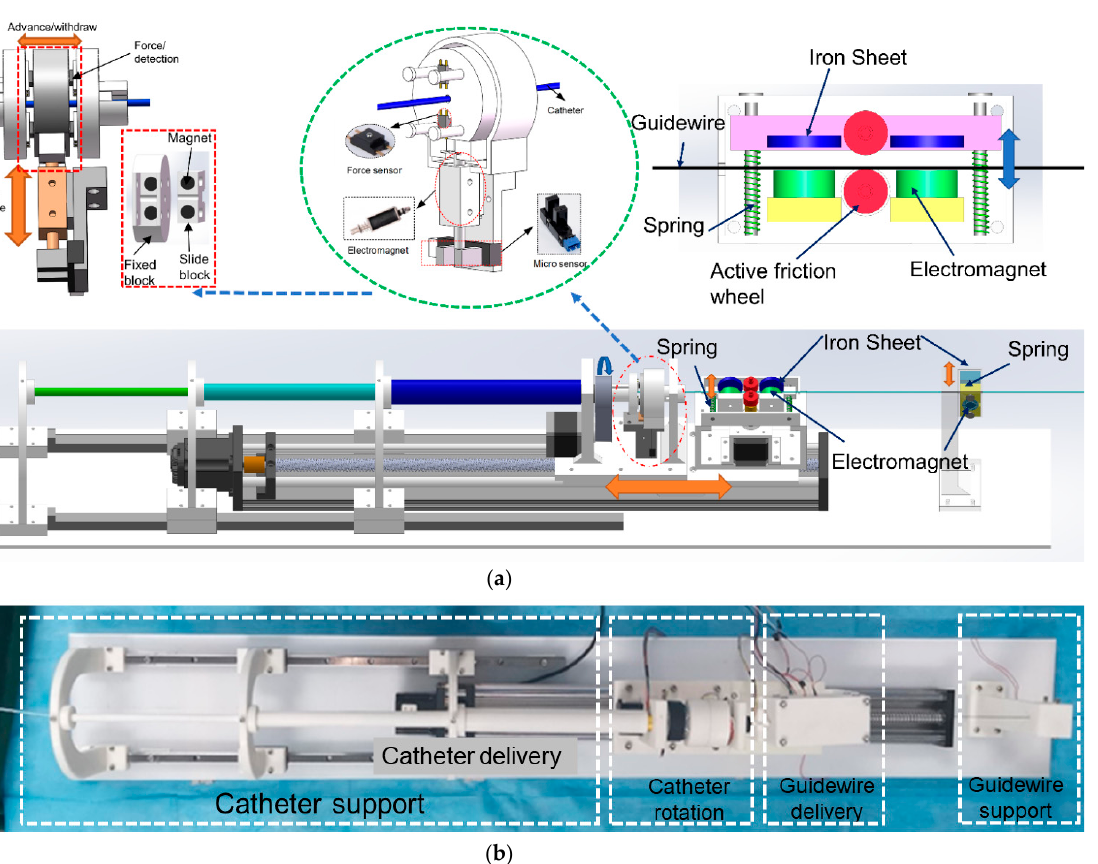
Figure 11. ( a ) Slave manipulator CAD structure. ( b ) The developed